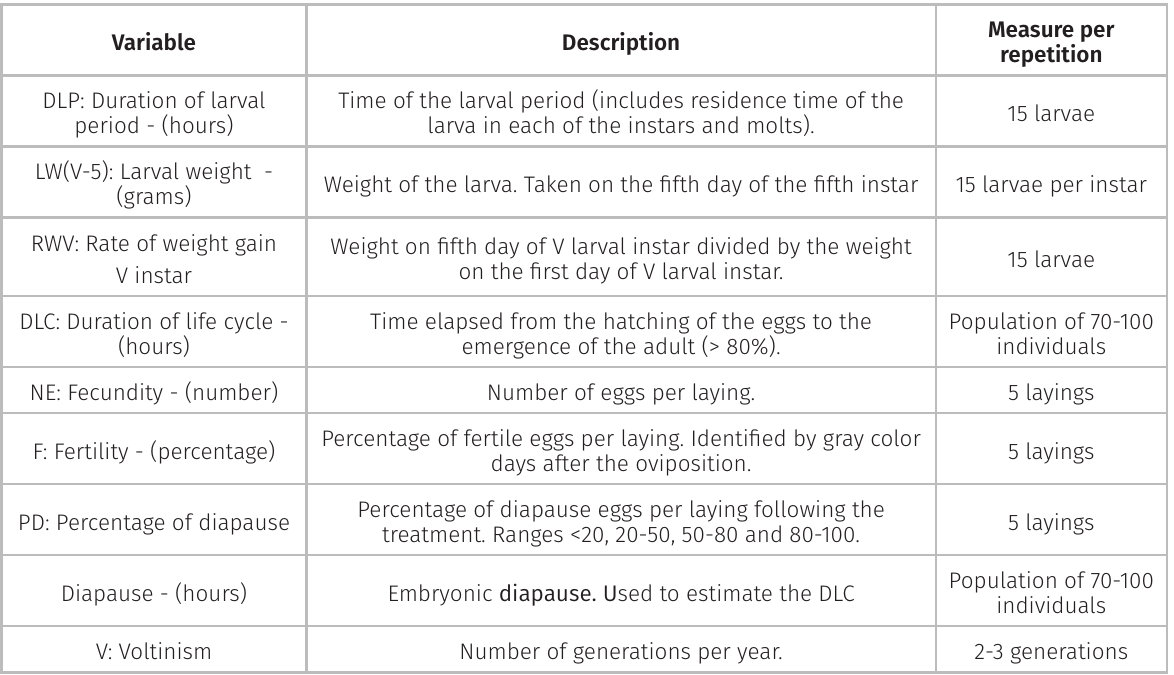
Table I. Biological variables for the study of voltinism in B. mori.